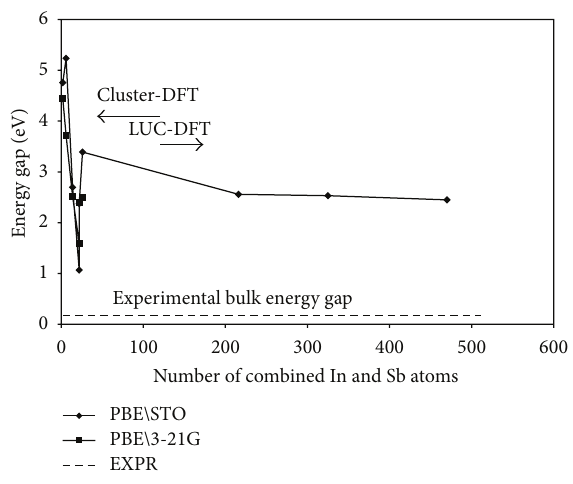
Figure 3: Energy gap as a function of combined number of In and Sb atoms. Relativistic corrections are incorporated in the present calculated values of the gap.